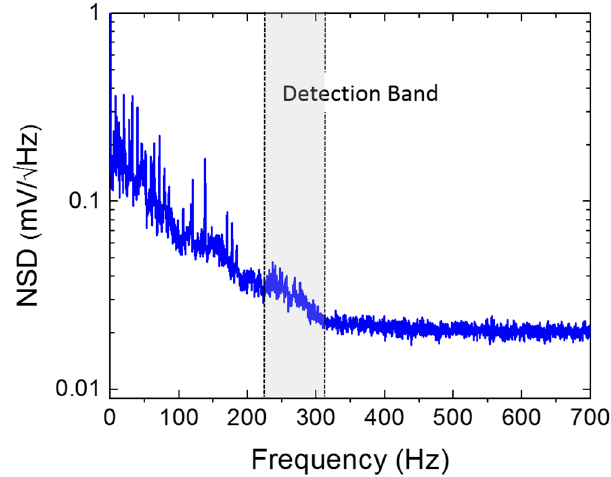
Figure 13. Measured noise spectral density of the two-wing sensor. The measurement was performed over a 6.5 kHz band inside an anechoic chamber with a noise floor of approximately 28 dB. The sensor readout electronics were programed with the same parameters used to obtain the results shown in Figure 12.